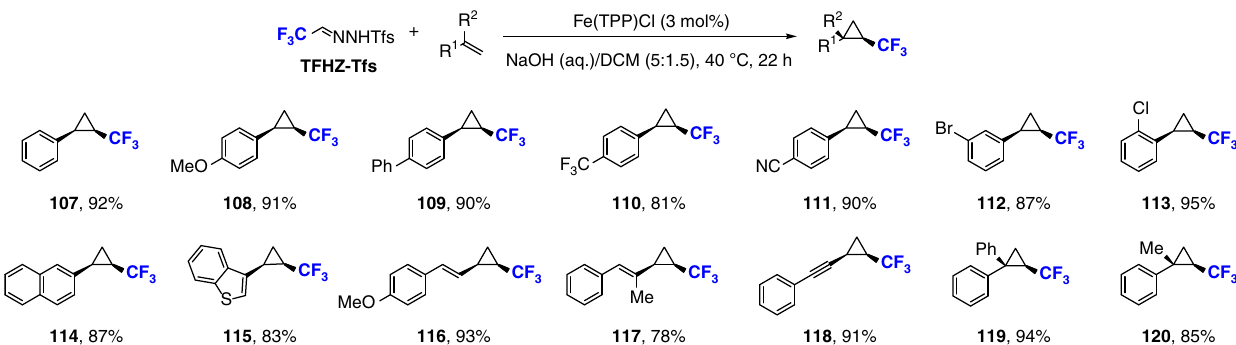
Fig. 8 Scope of tri fl uoromethylcyclopropanation. Reaction conditions: ole fi n (0.3 mmol), TFHZ-Tfs (0.6 mmol), FeTPPCl (3 mol%), NaOH (aq.)/DCM (5:1.5), 40 °C, 22